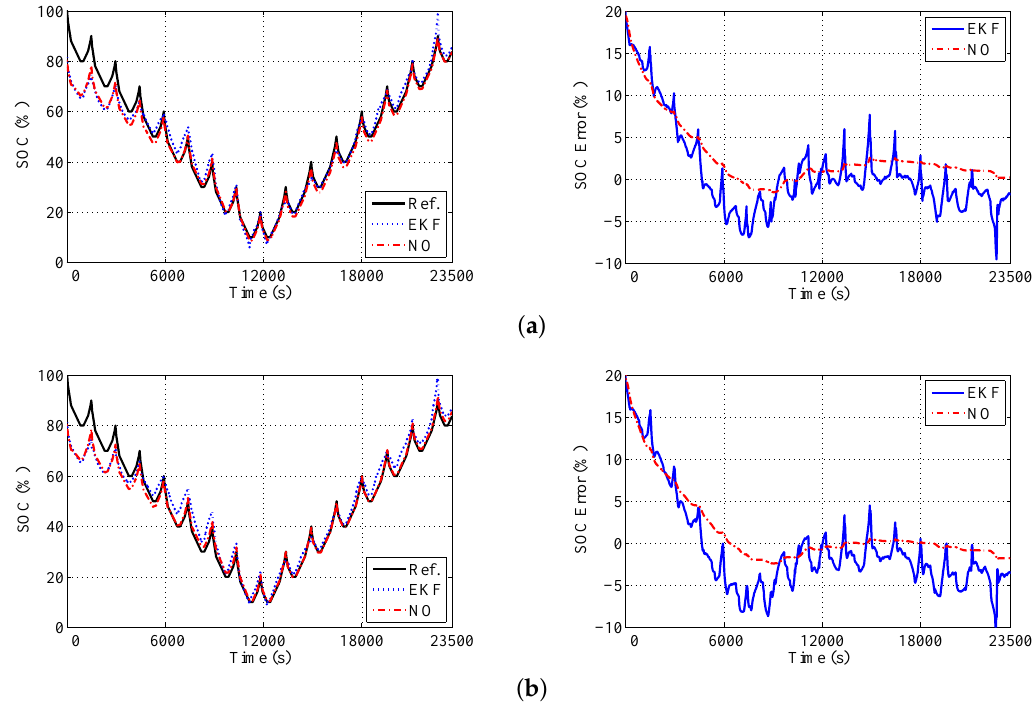
Figure 5. Estimation results of HPT datasets from two type 1 cells: ( a ) estimation results of cell 1; and ( b ) estimation results of cell